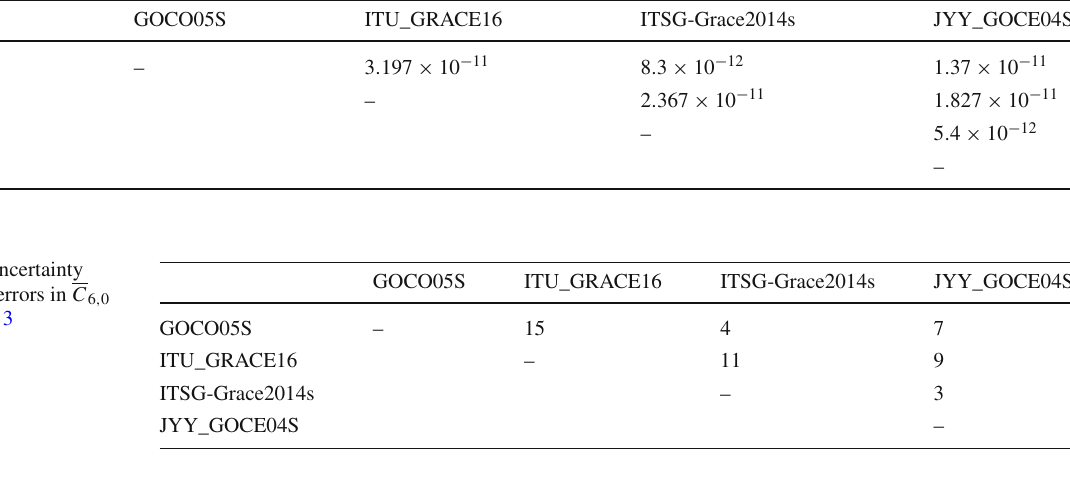
Table 3 Absolute values of the differences (cid:6) C 6 , 0 among the estimated values C 6 , 0 of the models of Table 2. They are very close to the uncer- tainties retrievable from the application of Eq. (A11) by Wagner and